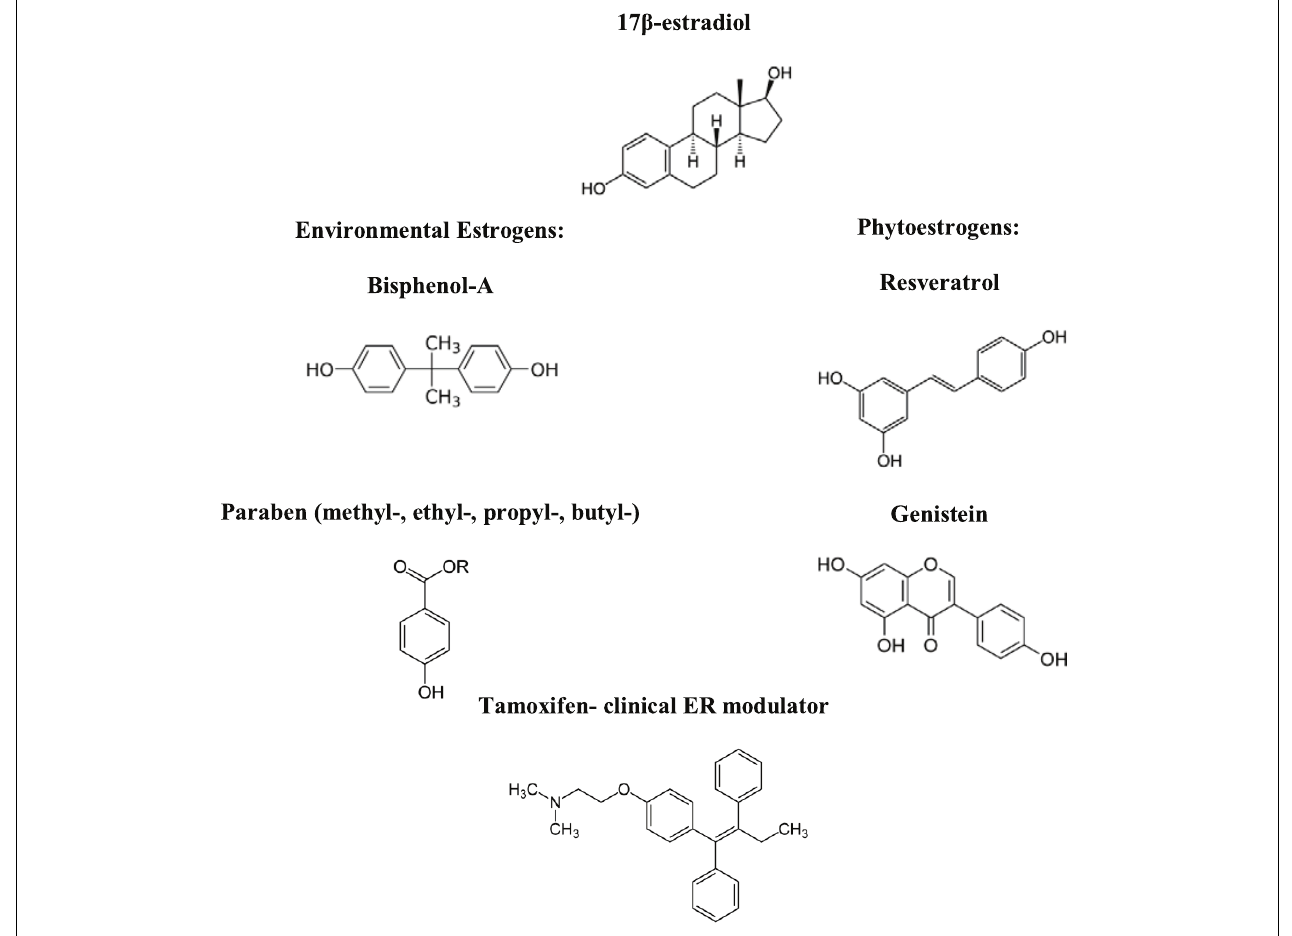
FIGURE 3 | Structures of common xenoestrogens capable of influencing estrogenic signaling through agonistic and/or antagonistic